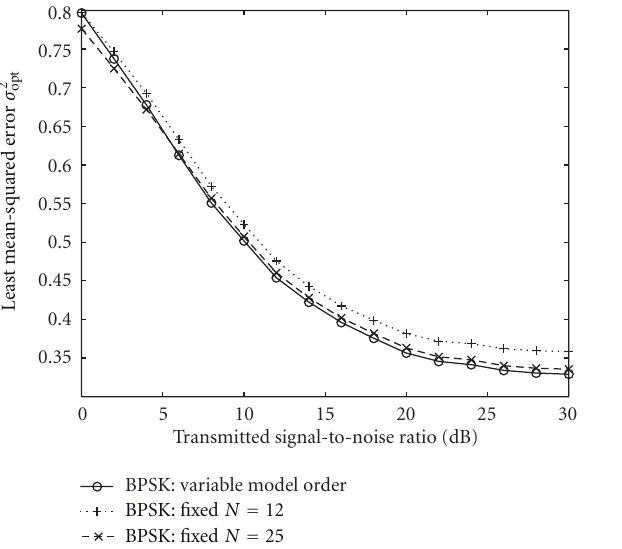
Figure 4: Various least mean-squared errors σ 2 noise ratio (the threshold for our variable model scheme is τ J = 1 / 200).